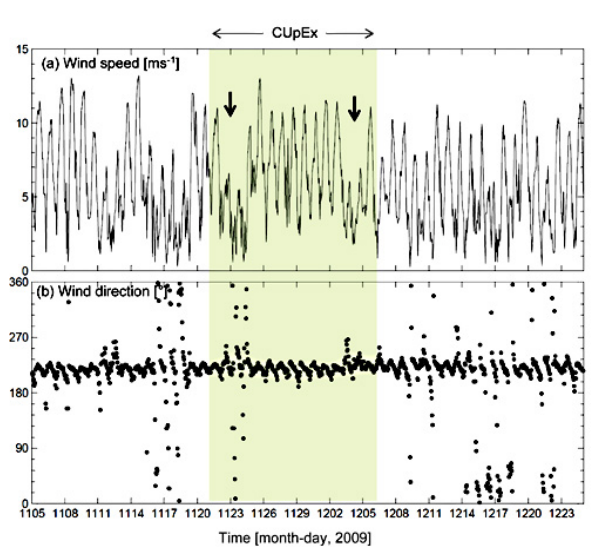
Fig. 4. Half-hourly records of wind speed (upper panel) and wind direction (bottom panel) panel at point Lengua de Vaca during November/December 2009. Central, colored area indicates CU- pEx period. The two vertical arrows indicate southerlies relaxation events.